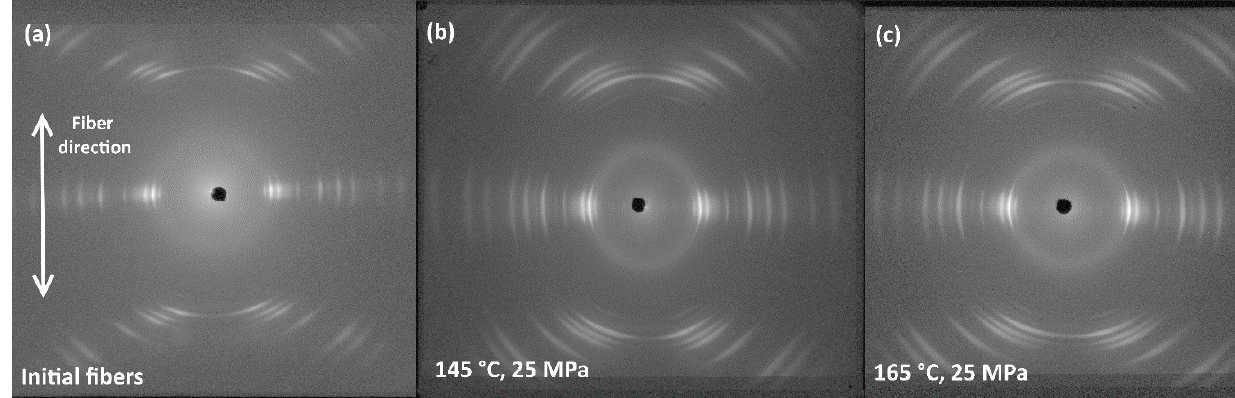
Figure 6. 2D WAXS patterns of ( a ) the pristine fibers and samples made at 25 MPa and ( b ) 145 °C and ( c ) 165 °C (Regime 1).